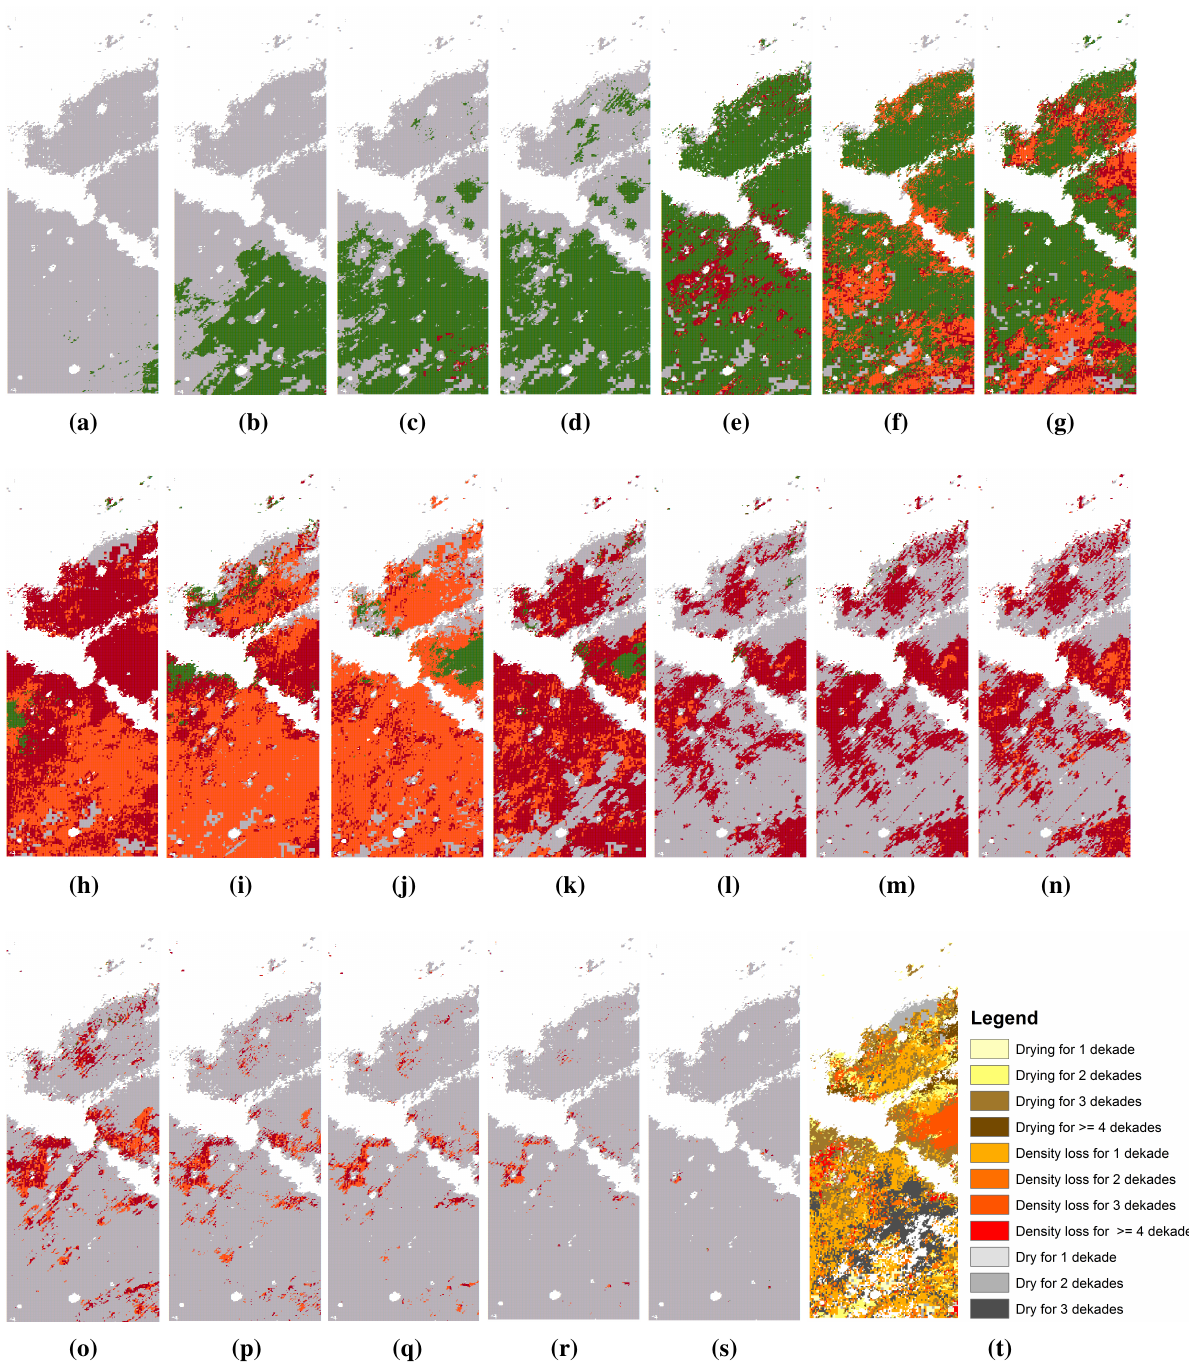
Figure 9. Classification into ∎ “growth”, ∎ “density reduction” and ∎ “drying” every 10-day from the 21/07/2010 to the 21/01/2011 ( a – s ). Map (t) summarizes the dynamic dryness status at the end of the second 10-day interval of October. It highlights areas less suitable for desert locusts (in grey and yellow